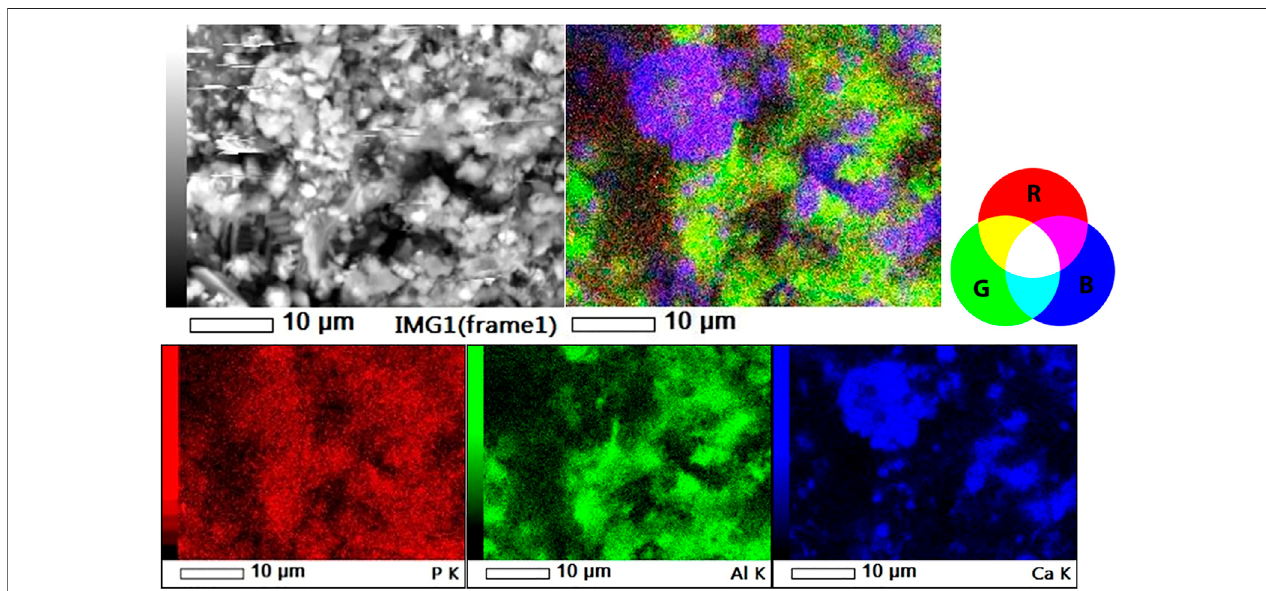
FIGURE 2| SL-Al/O-WTR in the back-scattered image (top left) , 3-elementoverlay image (top right) and individual dot maps ofP, Al and Ca ( lower left, center and right , respectively).